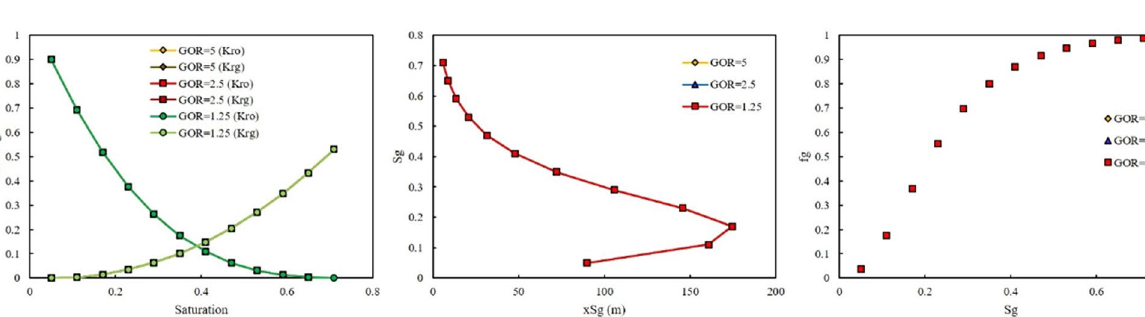
Figure 6. Effect of GOR of LPG on relative permeability, saturation profile, and fractional flow curve at an injection pressure of 500 psi.